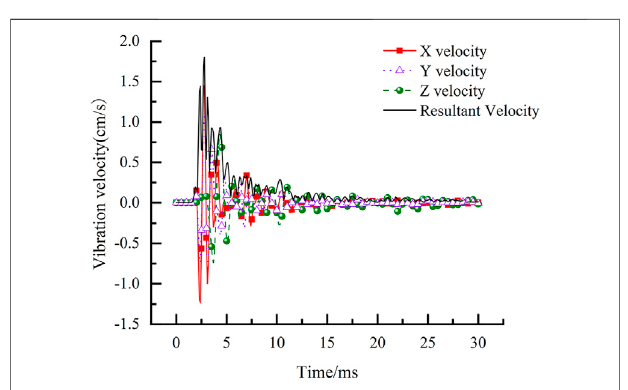
FIGURE 8 | The vibration velocity response of the Line 3 People ’ s Hall